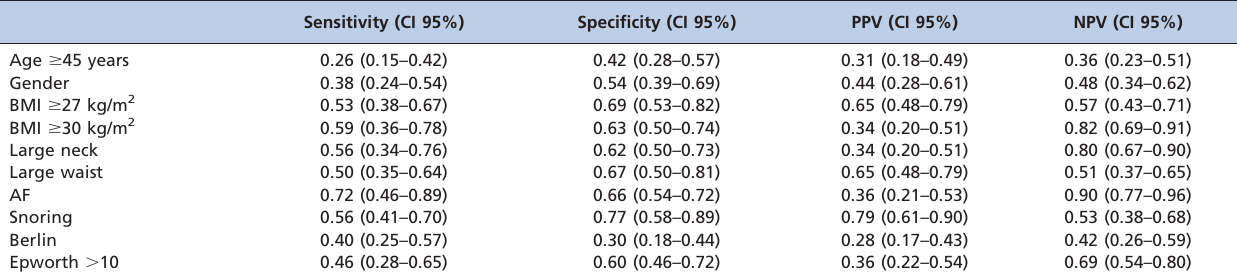
Table 4 - Performance of clinical and sleep-related characteristics of the HCM patients.